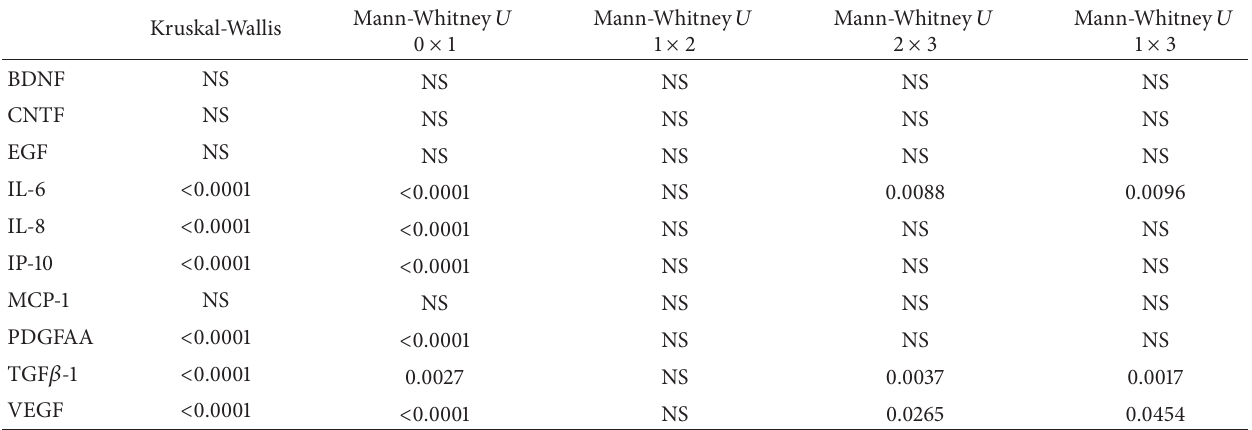
Table 2: Comparison of biomarker levels between groups. 𝑃 values are